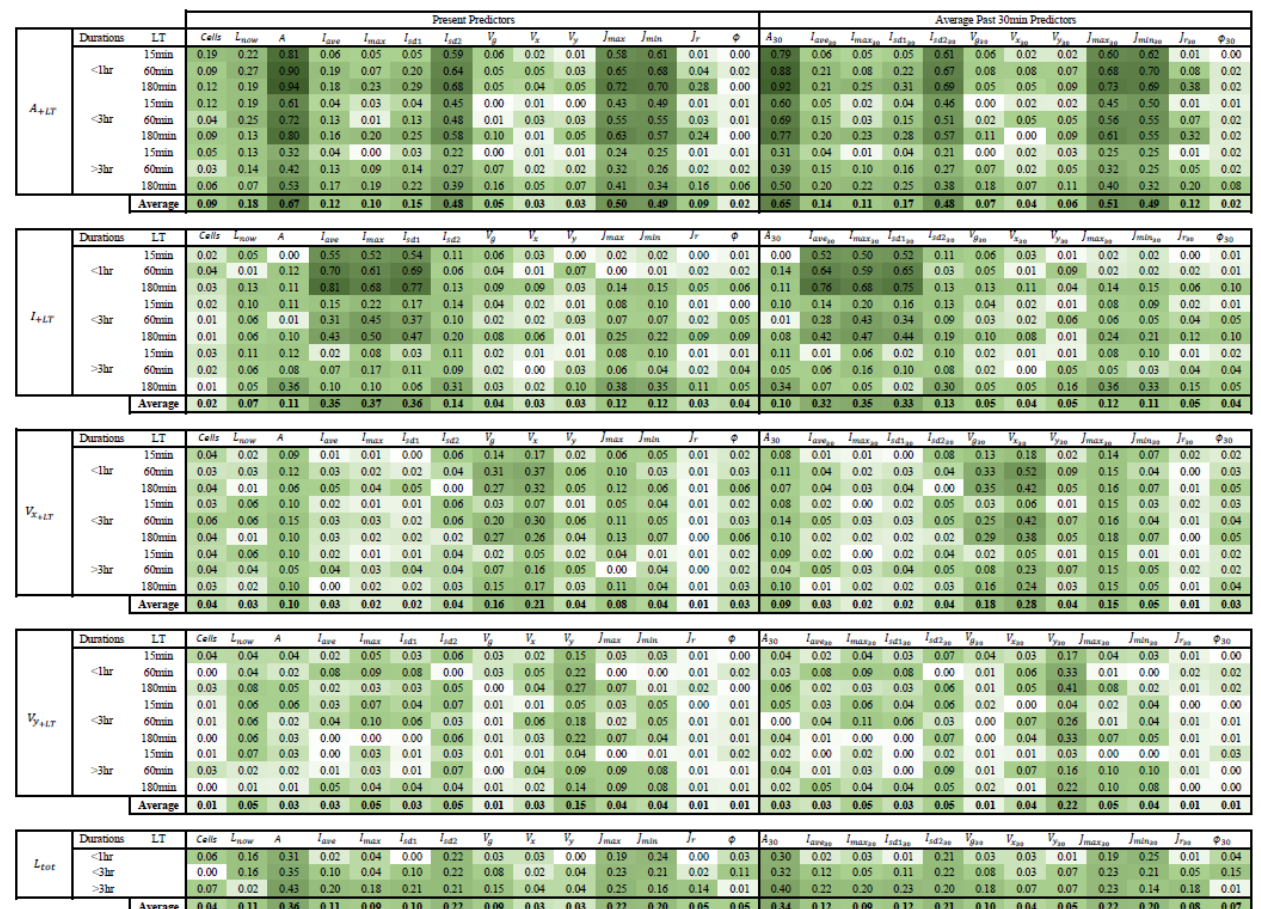
Table A1. Strength of the relationship between the selected predictors and the target variables averaged for three lead times and storm duration groups based on correlation values. The green shade indicates the strength of the relationship, with 0 for no relationship at all and 1 for the highest dependency. The averaged computed values for each target variable (last row) are used as bases for Table 3. The correlation weights are absolute values of the correlation values between the predictors at specific lead times and target